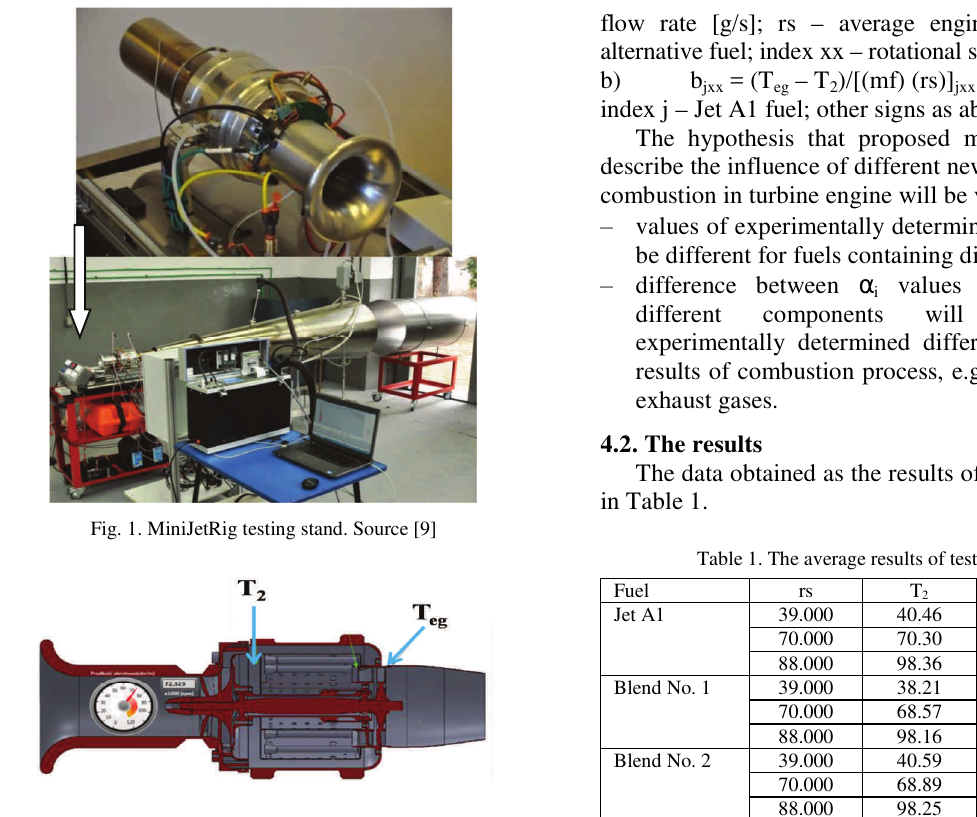
Fig. 2. The scheme of the engine used in verification of the proposed model [9]